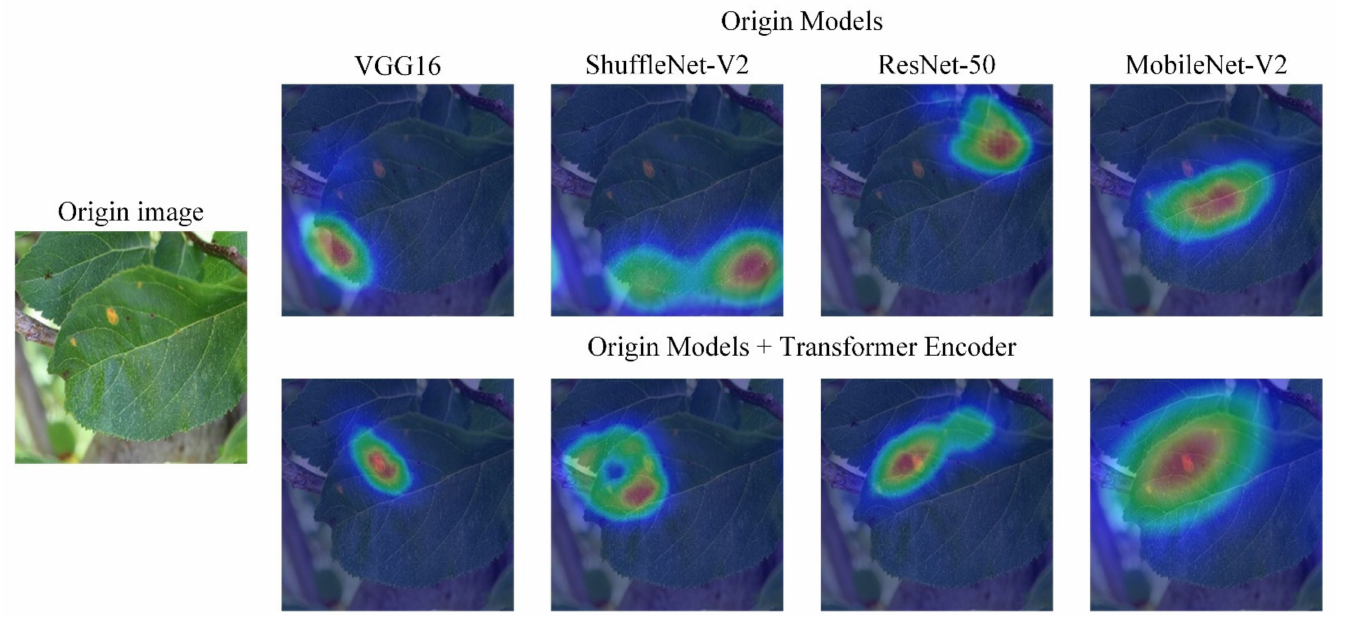
Figure 11. Visual analysis of regions of interest of different